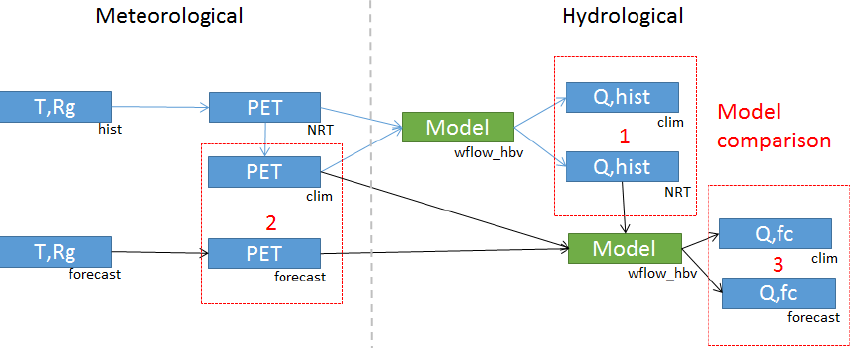
Figure 3. Flow chart of the model experiment. Blue boxes represent data products. Green boxes depict modeling activities. Arrows represent the flow of data for historical runs (blue lines) and forecast runs (black). The red boxes indicate the areas for analysis of the results, each box targeting a research